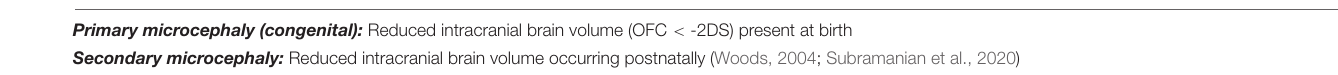
TABLE 2 | MCD classification and representative examples of MCD-causing genes as well as IPSCs, COs and zebrafish models: the table summarizes the clinical classification and the disease mechanisms underlying different forms of MCD. Known genetic alterations Representative zebrafish, IPSCs-derived neurons and COs models to study mechanisms underlying MCD Impaired neurogenesis and neural